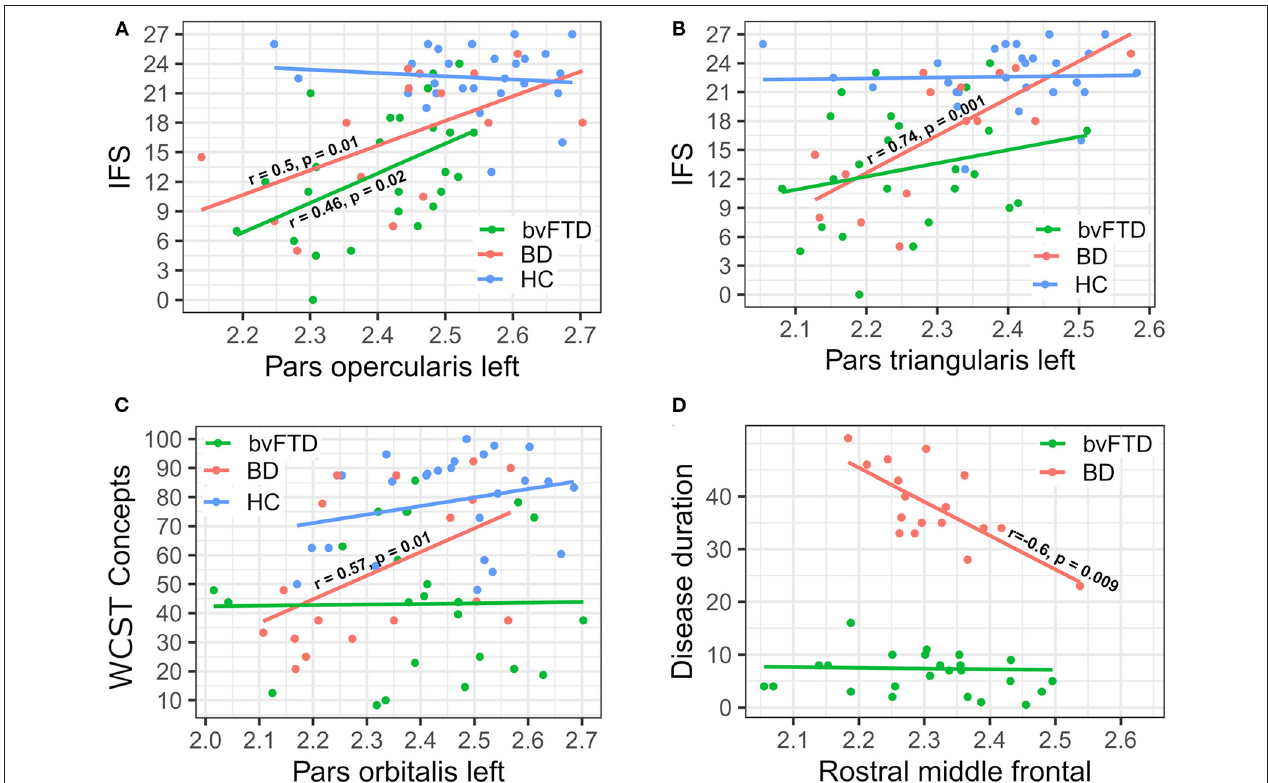
FIGURE 3 | Correlations between cortical thickness and clinical variables. (A) IFS vs. Pars opercularis left; (B) IFS vs. Pars triangularis left; (C) WCST Concepts vs. Pars orbitalis left; and (D) disease duration vs. rostral middle frontal. IFS, INECO Frontal Screening; WCST, Wisconsin Card Sorting